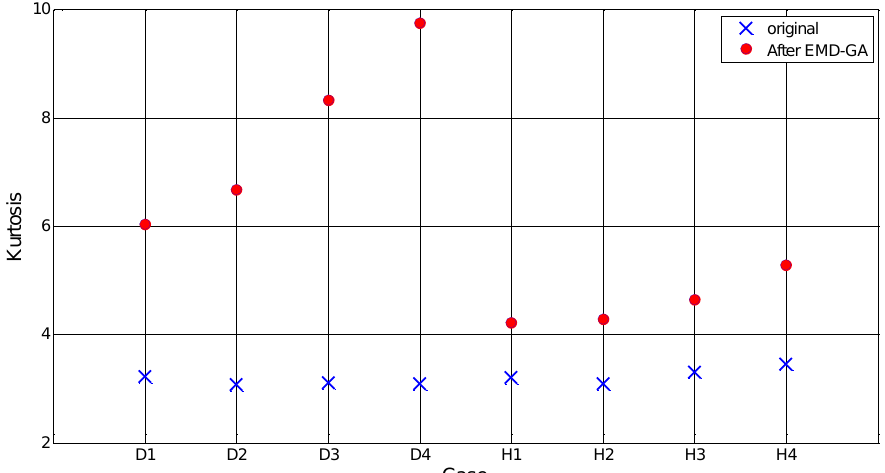
Figure 14. Overall comparison of kurtosis values before and after applying EMD-GA on the bearing